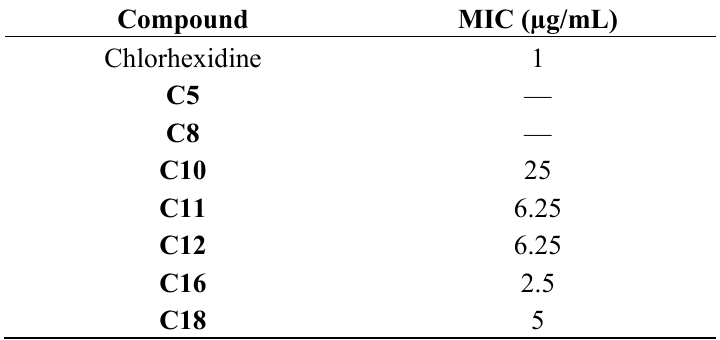
Table 1. MIC results of synthesized monomers and